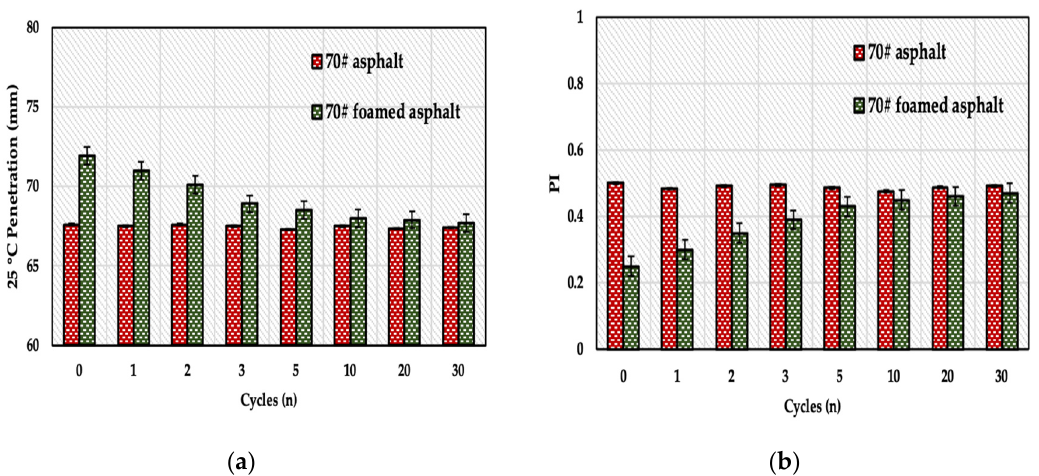
Figure 3. Penetration test results of samples with high-temperature evaporation cycles: ( a ) 25 °C penetration and ( b ) penetration index.